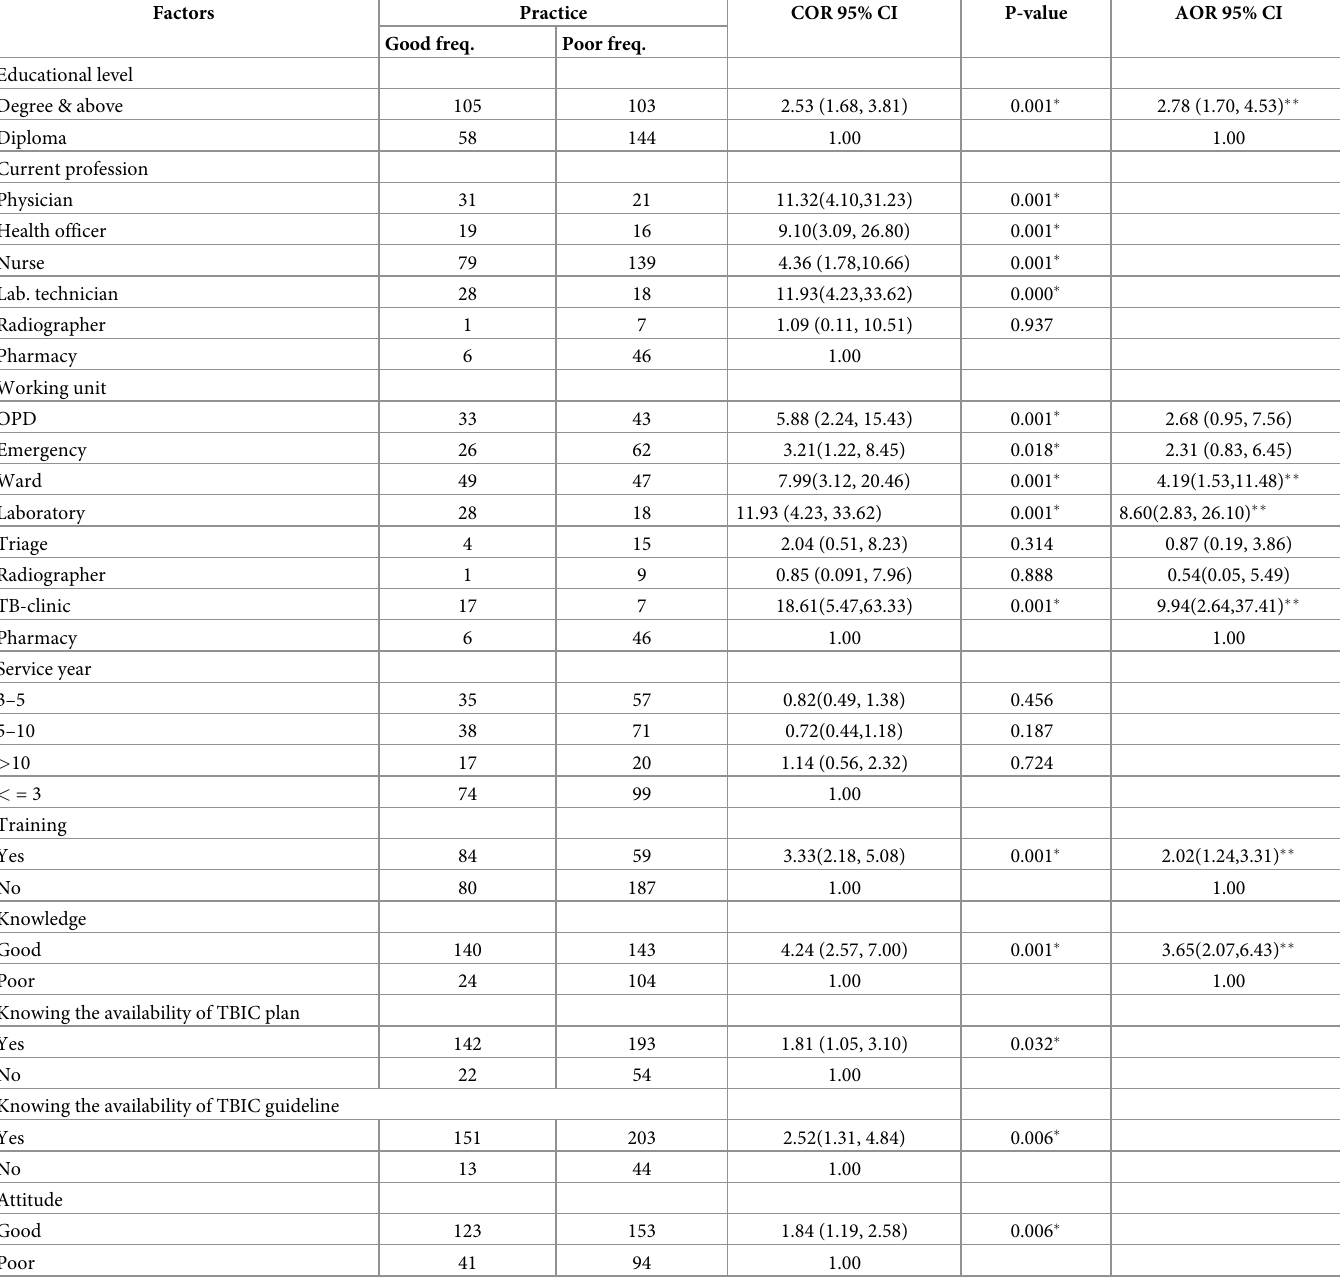
� = variables candidate for multivariate logistic